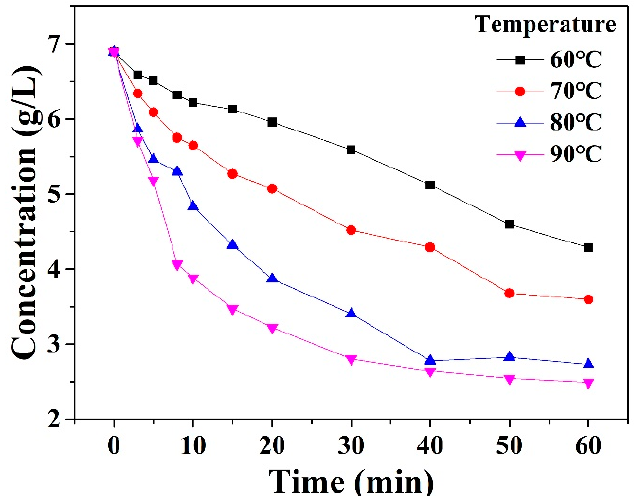
Figure 8. Effect of temperature on thermal decomposition crystallization [agitation speed = 300 rpm].